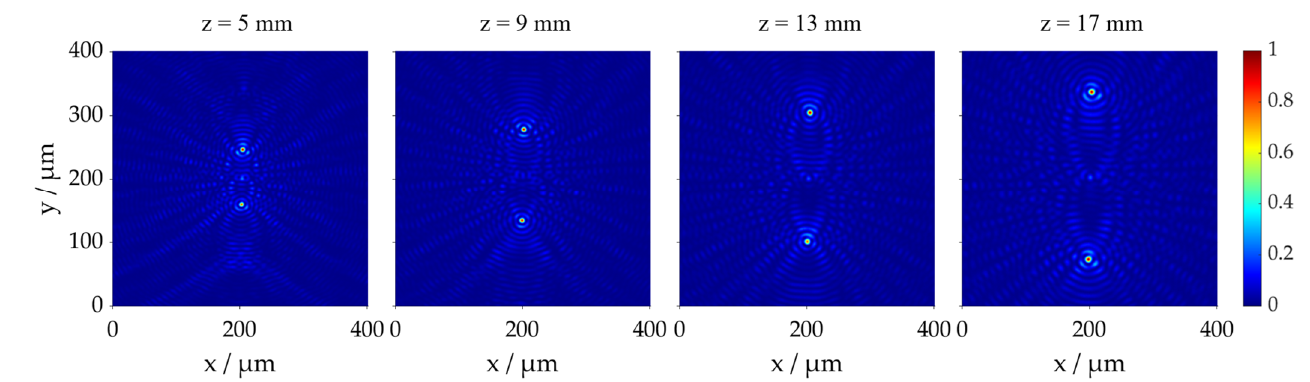
Figure 6. Measured lateral intensity distributions of the multi-Bessel beam in the focal plane after lens 3 taken in different z-axis positions from 5 mm to 17 mm in 4 mm steps.